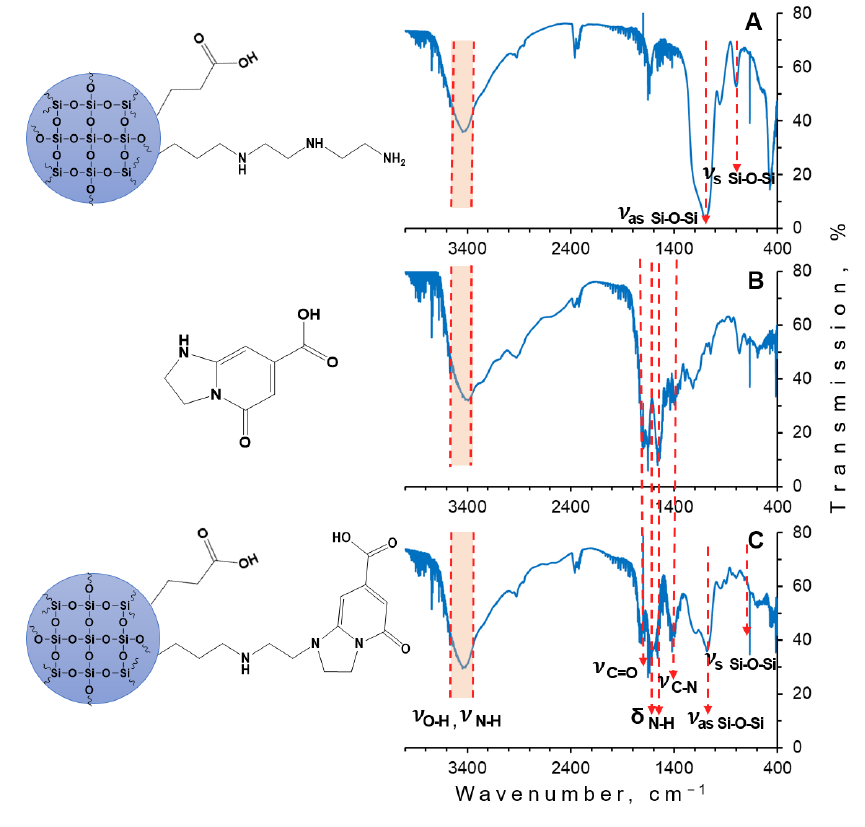
Figure 7. FTIR spectra of silica nanoparticles ( A ), IPCA molecular fluorophore ( B ), and luminescent composite nanoparticles ( C